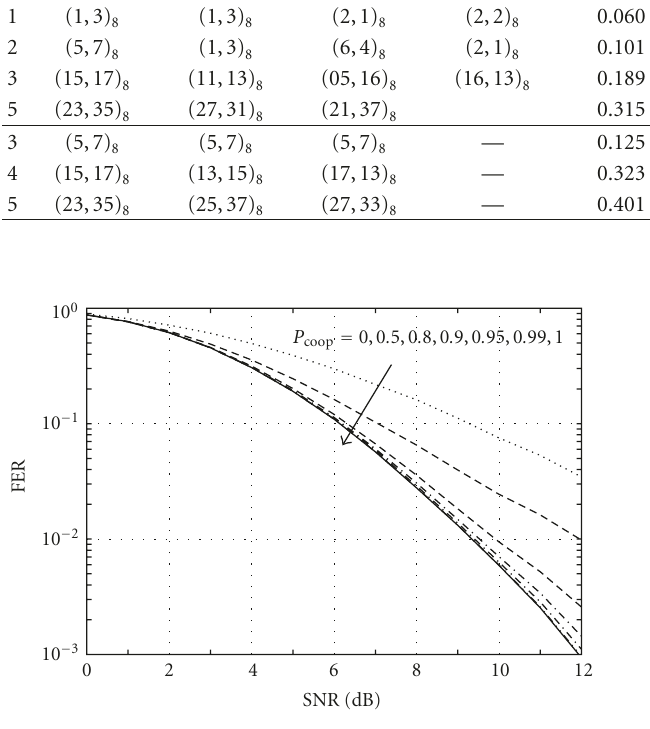
Table 5: Optimum overlays for rate 1 / (2 R ) COP-STC with QPSK, n = 1, m = 1, R ∈ { 1,2,3 } , in quasistatic channel. The basic code for a single transmitter is the best convolutional code for the AWGN channel. The bottom part of the table refers to C-STC as in [12]. Generators μ